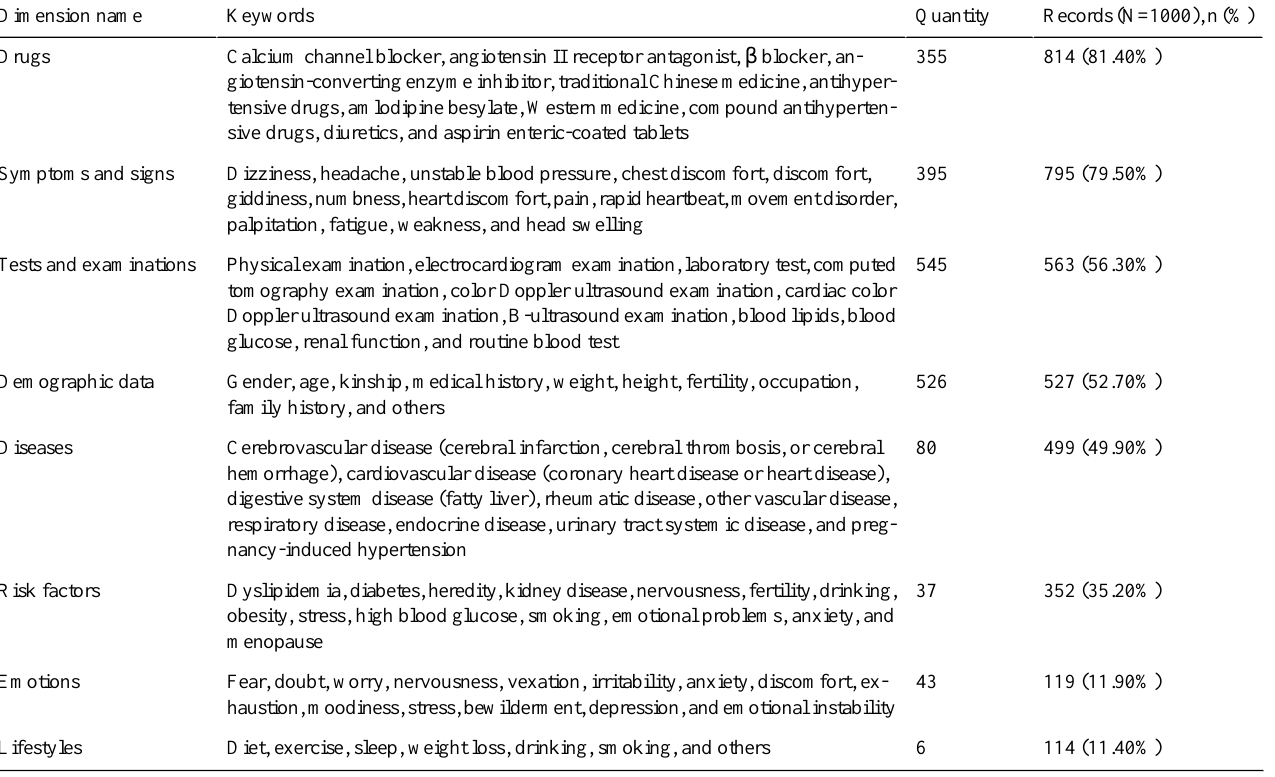
Table 1. Frequency distribution of the background dimension system.